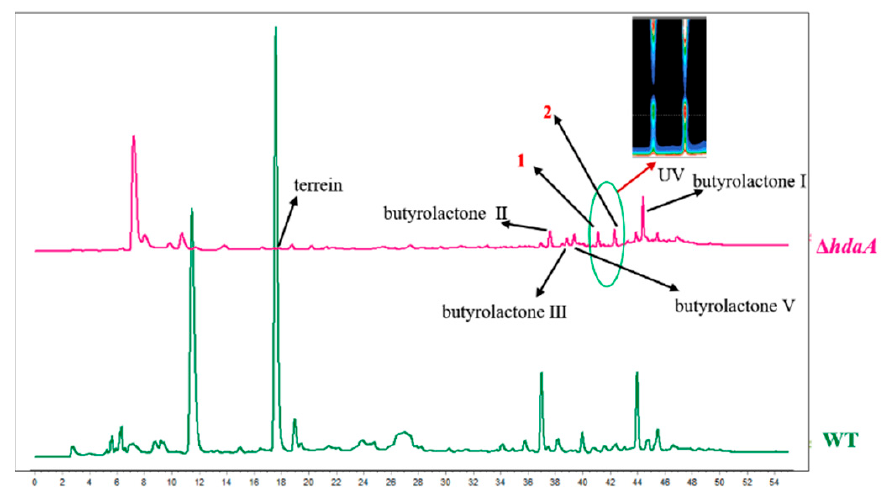
Figure 4. HPLC analysis of the secondary metabolite profiles of WT strain and ∆ hdaA strain.